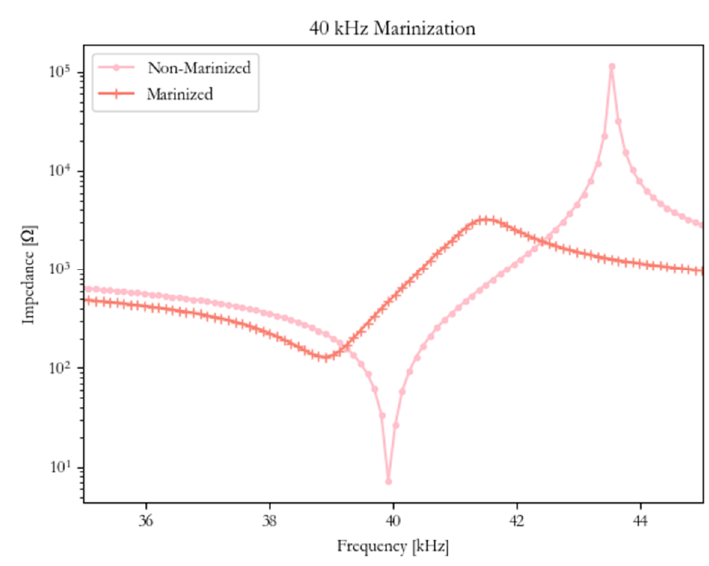
Figure 4. Impedance characterization of 40 kHz HPUT before and after marinization.